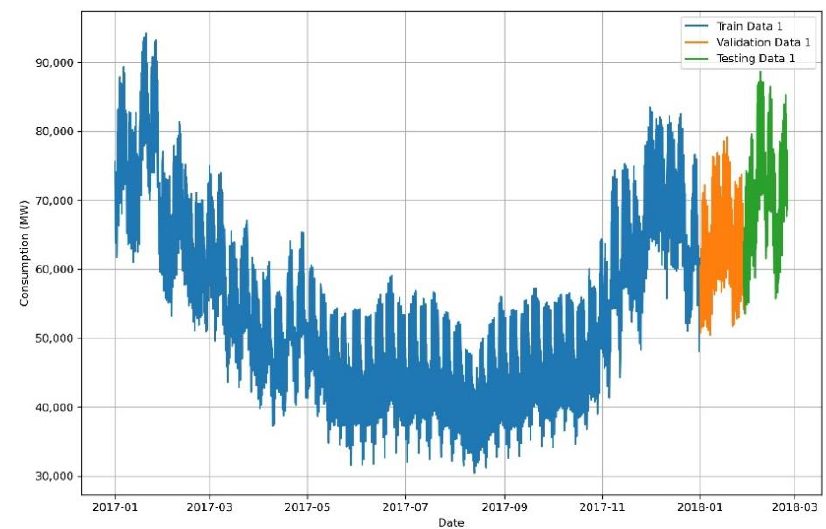
Figure 4. Power consumption for the data division 1.